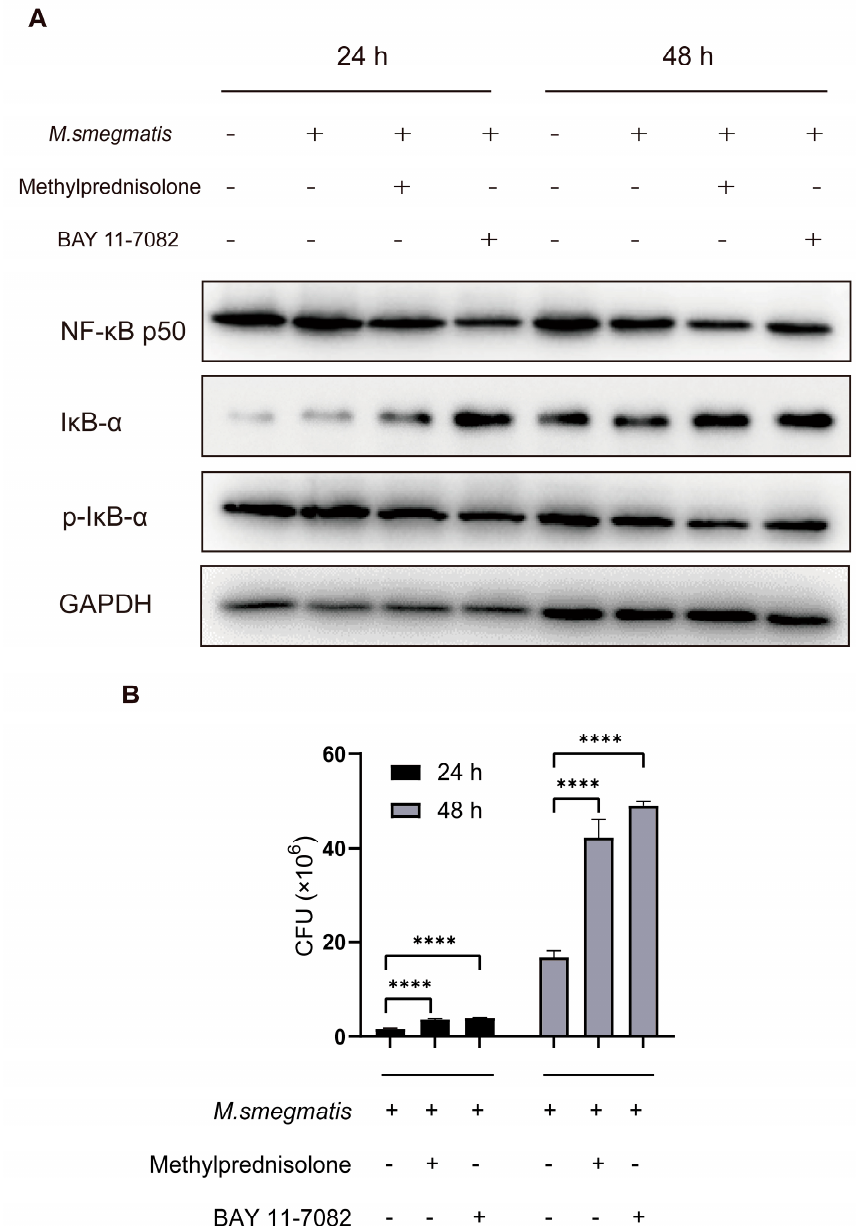
Figure 2. ( A ) Methylprednisolone (10 2 µ M) and the NF- κ B inhibitor BAY 11-7082 (2 µ M) treated M. smegmatis infected RAW264.7 cells for 24 and 48 h; NF- κ B p50, I κ B- α , and p-I κ B- α levels were detected with Western blot analysis. ( B ) CFU results of RAW264.7 cells infected with M. smegmatis after treatment with methylprednisolone (10 2 µ M) and NF- κ B inhibitor BAY 11-7082 (2 µ M) for 24 h and 48 h; the analysis of variance was used for data analysis; **** p <